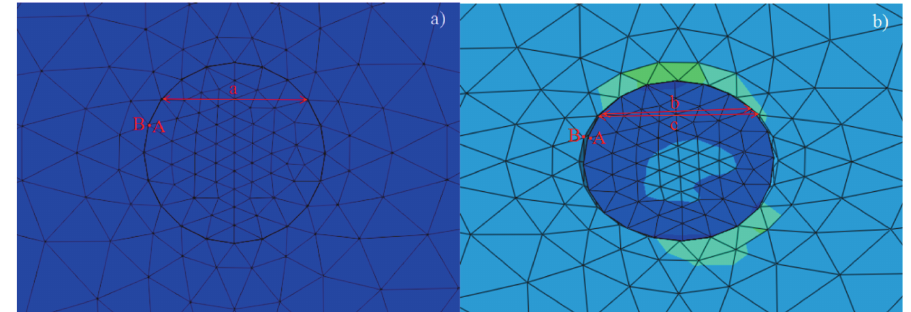
Figure 7: The length before and after rolling: a) before rolling; b) after rolling.